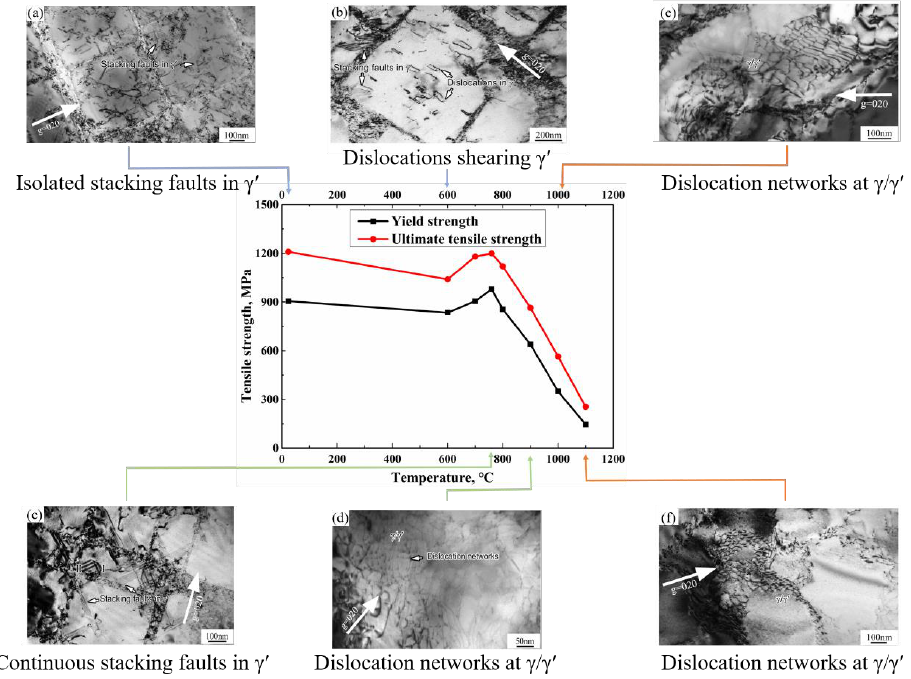
Figure 8. The tensile properties and corresponding deformation microstructures of M951G alloy at various temperatures. ( a ) RT; ( b ) 600 °C; ( c ) 760 °C; ( d ) 900 °C; ( e ) 1000 °C; ( f ) 1100 °C.